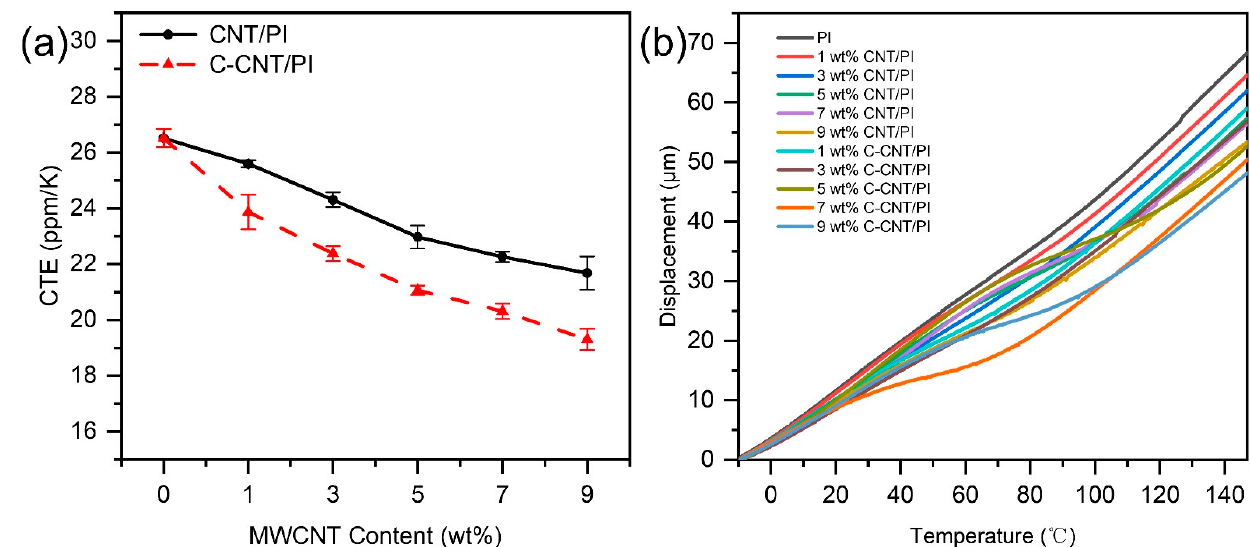
Figure 11. ( a ) Summary of the CTE values of PI films with different contents of CNT and C-CNT and ( b ) TMA curves of PI, CNT/PI and C-CNT/PI films.